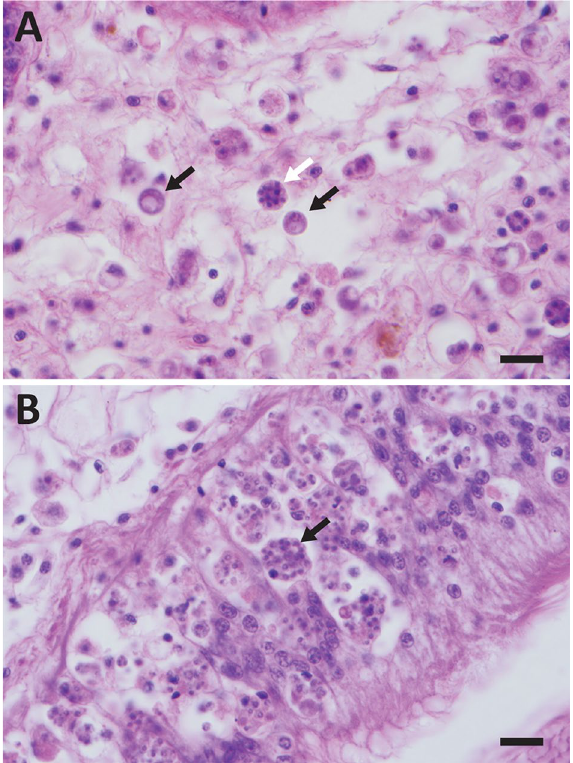
Figure 1. Histological presentation of Perkinsus marinus phenotypes. A. Original phenotype, with relatively small numbers of large P. marinus cells primarily infecting oyster connective tissues. Black arrows indicate two P. marinus trophozoites; white arrow indicates a multinucleate schizont. B. Contemporary phenotype, with large numbers of small parasite cells primarily infecting digestive epithelia. Arrow indicates a mass of P. marinus cells inside a moribund oyster hemocyte. Scale bars for both panels represent 20 microns.